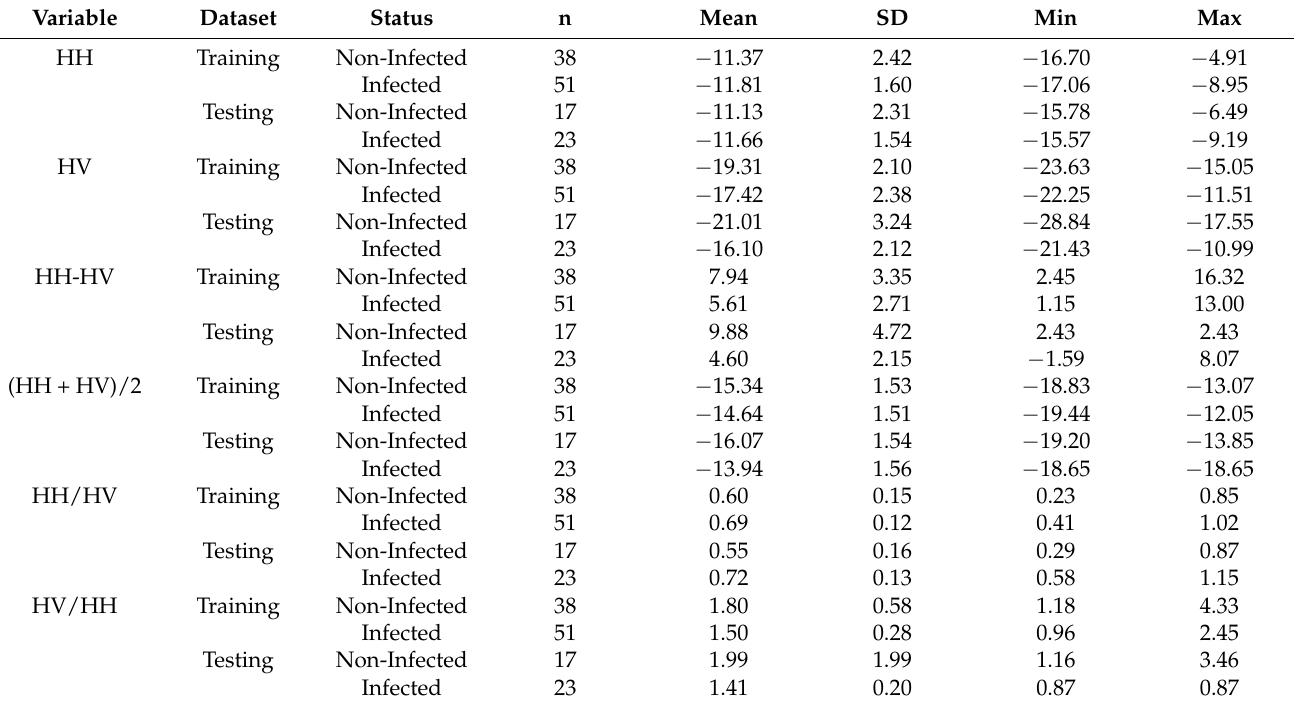
Table 5. Descriptive statistics of variables gained from the backscatter of dual polarization